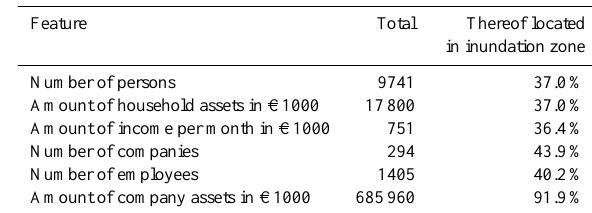
Table 6. Exposed assets in Khao